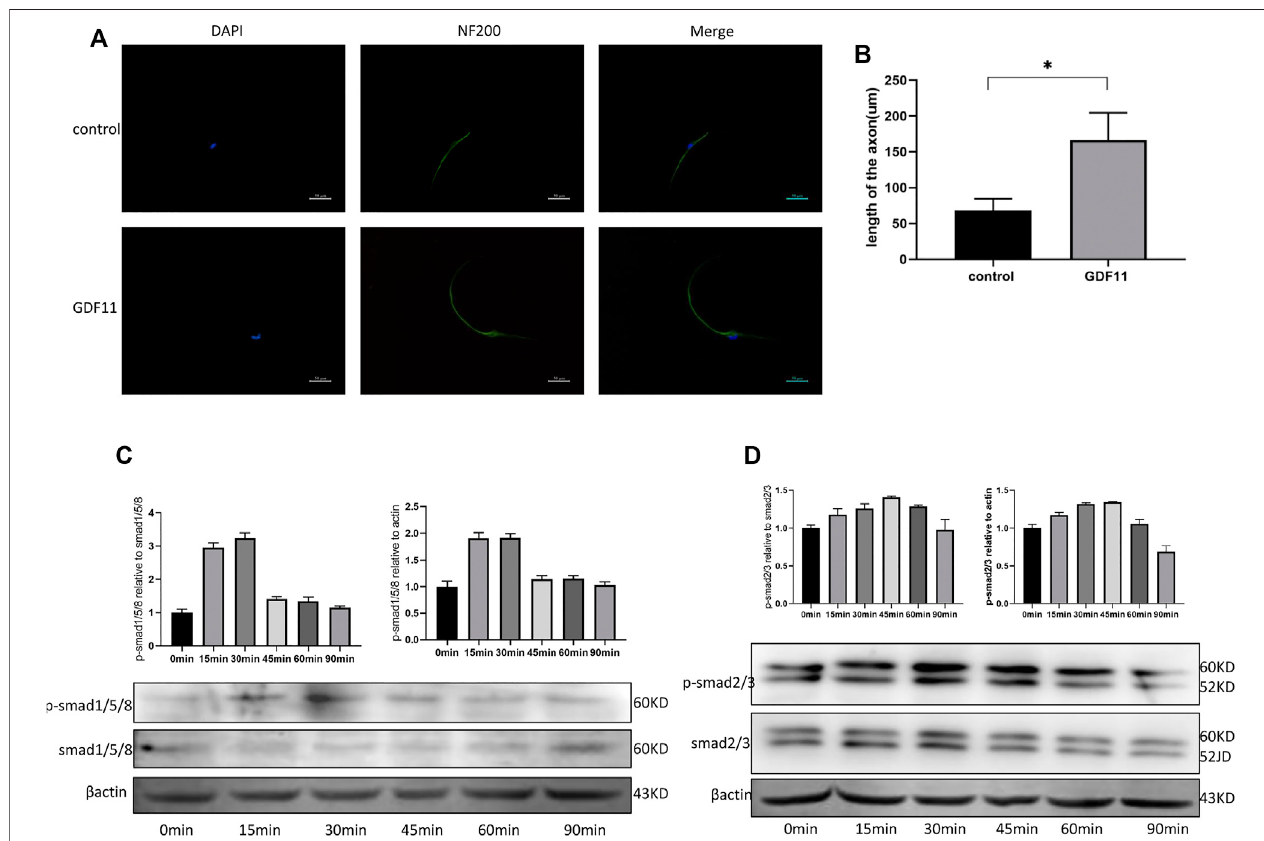
FIGURE 3 | GDF11 promotes axonal growth of DRG cells in vitro . (A and B). After DRG cells were cultured with recombinant GDF11 for 7 days, axon length was measured by NF200 immuno fl uorescence. (C). Western analysis showed increased phosphorylation of Smad1/5/8 when DRG cells were treated with GDF11. (D). Western analysis showed increased phosphorylation of Smad2/3 when DRG cells were treated with GDF11. Statistical analysis was based on at least three different biological samples and three technical replicates, p < 0.05 was considered to be statistically signi fi cant. Representative images are shown.